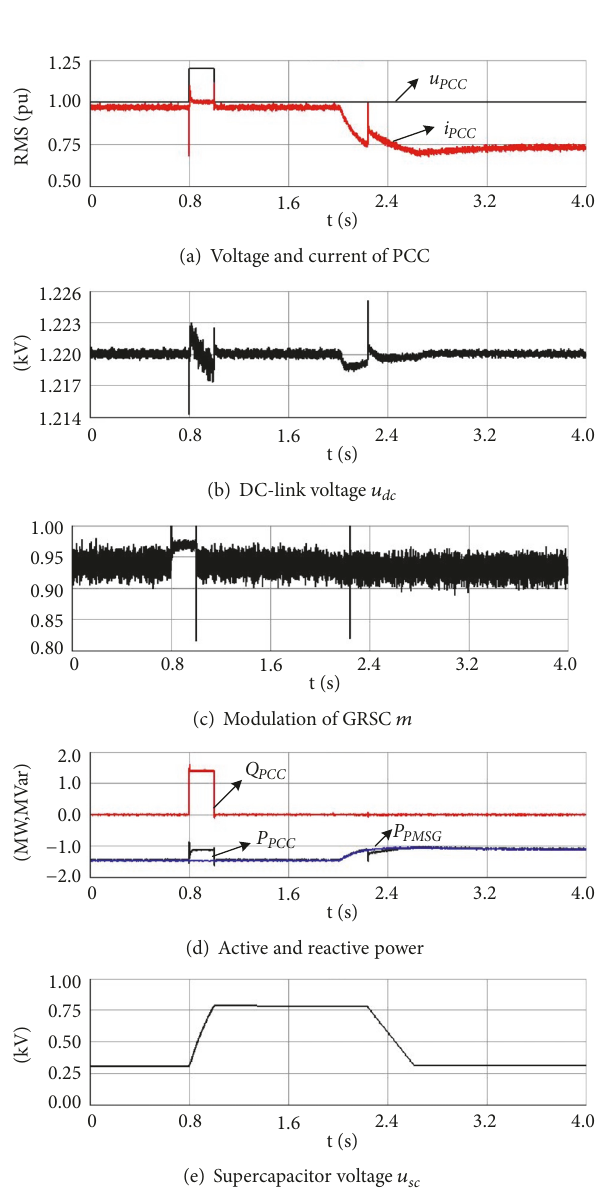
Figure 9: HiL results of GRSC with SCESU under voltage swell